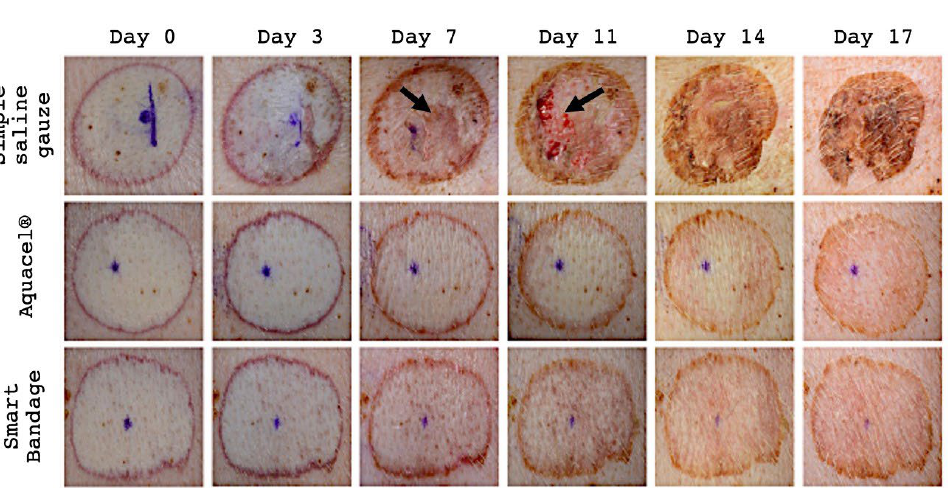
Figure 1. Representative image of burn (out of total n = 6) wounds treated with simple saline gauze, Aquacel ® , Smart Bandage (INTELIGELS Ltd. Hoshaya, Israel) over a 17-day experimental period. The healing process in simple saline gauze areas demonstrates delayed healing, resulting in significant crusting. Arrows depict significant crusting on day seven and newly generated dermis damage on day 11 when simple saline gauze is used. While in both the Aquacel ® and Smart Bandage (INTELIGELS Ltd. Hoshaya, Israel), the healing process seems to demonstrate similar results.